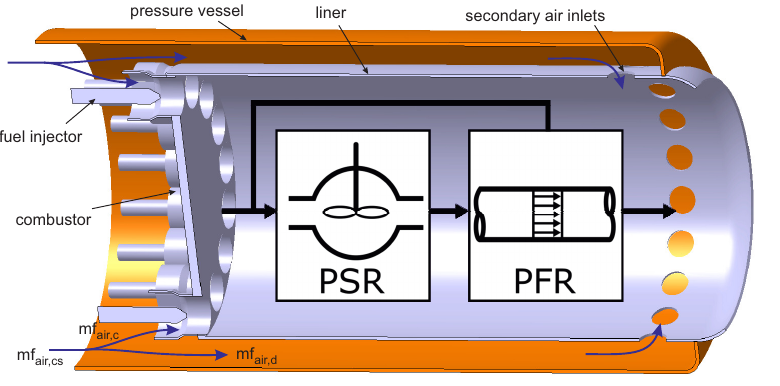
Figure 2. Generic setup of each of the FLOX-based can combustors, together with the schematic of reactor